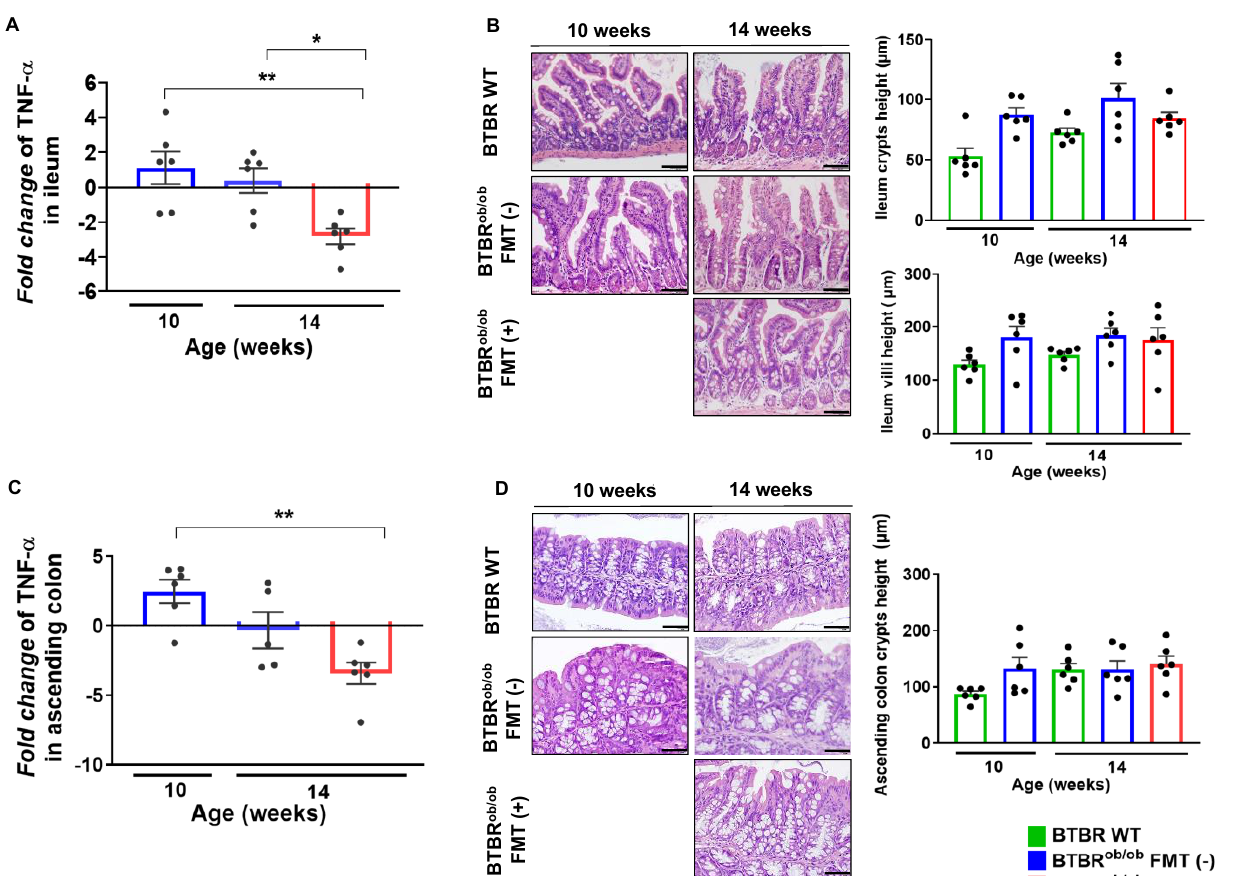
Figure 6. Evaluation of gene expression and morphological aspects of intestinal crypts and villi in BTBR ob/ob FMT (-) and BTBR ob/ob FMT (+) mice compared to BTBR WT mice. ( A ) Fold change of TNF- α expression in the ileum from age-matched BTBR WT: TNF- α expression of 14 -week-old BTBR ob/ob FMT (+) mice was significantly downregulated when compared to 10-week-old BTBR ob/ob mice (** p = 0.004) and 14-week-old BTBR ob/ob FMT (-) mice (* p = 0.02). No significant difference was found between 10-week-old BTBR ob/ob versus 14-week-old BTBR ob/ob FMT (-) mice ( p = 0.76). ( B ) Representa- tive hematoxylin-eosin (HE) staining of the morphological evaluation of ileum crypts from 10-week- old BTBR ob/ob compared to age-matched BTBR WT showed no difference in crypt height ( p = 0.08), also from 14-week-old BTBR WT versus 14-week-old BTBR ob/ob FMT (-) ( p = 0.49) and FMT (+) ( p > 0.99) mice. No difference was observed between 14-week-old BTBR ob/ob FMT (-) and FMT (+) mice ( p > 0.99). Furthermore, no difference was found in the villi of this segment in 10-week-old BTBR ob/ob mice and age-matched BTBR WT mice ( p = 0.16), and between 14-week-old BTBR WT and 14-week- old BTBR ob/ob mice FMT (-) ( p > 0.99) and FMT (+) ( p > 0.99) mice. No difference was observed be- tween 14-week-old BTBR ob/ob FMT (-) and FMT (+) mice ( p = 0.99). ( C ) Fold change of TNF- α expres- sion in the ascending colon relative to age-matched BTBR WT: TNF- α expression of 14 -week-old BTBR ob/ob FMT (+) mice was significantly downregulated when compared to 10-week-old BTBR ob/ob mice (** p = 0.0014),but was not significantly different from 14-week-old BTBR ob/ob FMT (-) mice ( p =0.1). (D) Representative hematoxylin-eosin (HE) staining from morphological assessment of as- cending colon crypts in 10-week-old BTBR ob/ob mice and age-matched BTBR WT and 14-week-old BTBR WT mice in comparison to BTBR ob/ob FMT (-) and FMT (+) mice. The data showed no difference in the height of 10-week-old BTBR ob/ob crypts when compared to age-matched BTBR WT ( p = 0.18) mice and between 14-week-old BTBR WT and 14-week-old BTBR ob/ob FMT (-) ( p > 0.99) and FMT (+) ( p = 0.99) mice. There was no difference between 14-week-old BTBR ob/ob FMT (-) and FMT (+) mice ( p = 0.99). All data are means ± SEM. Scale bars represent 50 µm in (B) and 20 µm in ( D ). In all analyses, n = 5 – 6/group.